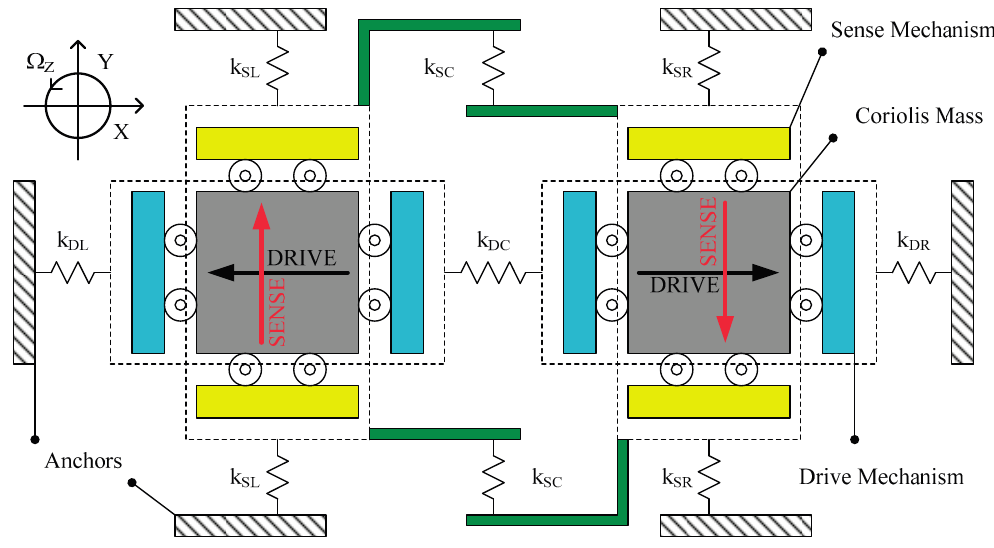
Figure 1. Schematic of a tuning fork micro-gyroscope with mechanically coupled drive mode and sense